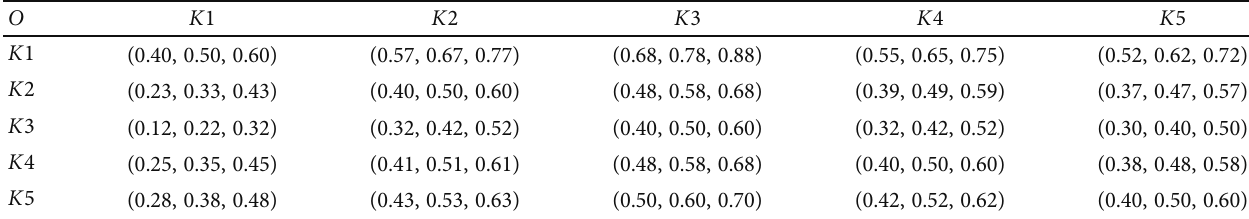
Table 5: O - K comprehensive fuzzy judgment matrix.